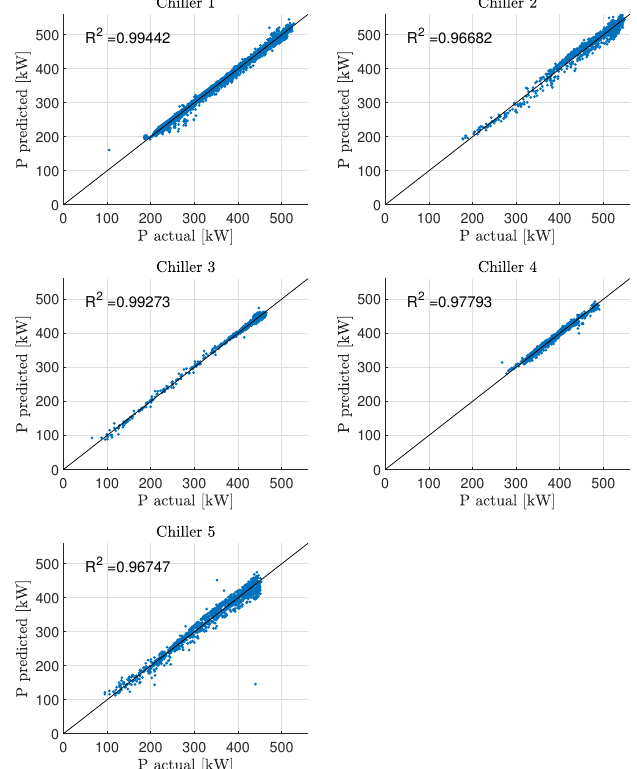
Figure 6. Goodness-of-Fit (GOF) plots of the quadratic power consumption models. Blue dots are the validation data.